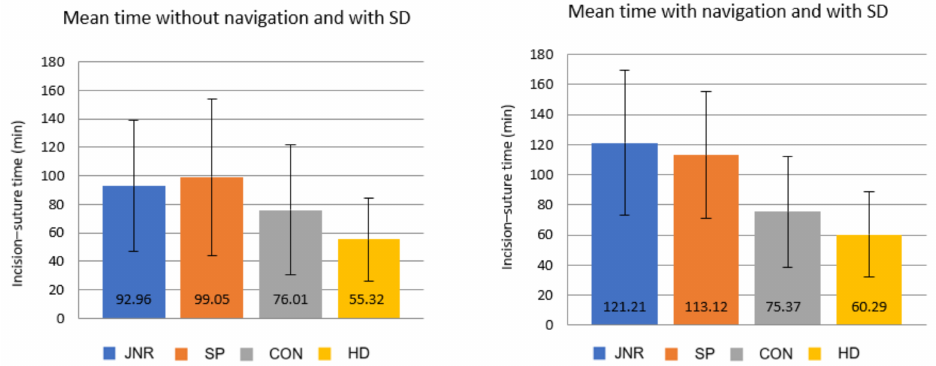
Figure 6. Mean time without and with navigation with standard deviation (SD); (JNR: Junior Doctor; SP: Specialist; CON: Consultant; HD: Head of Department).